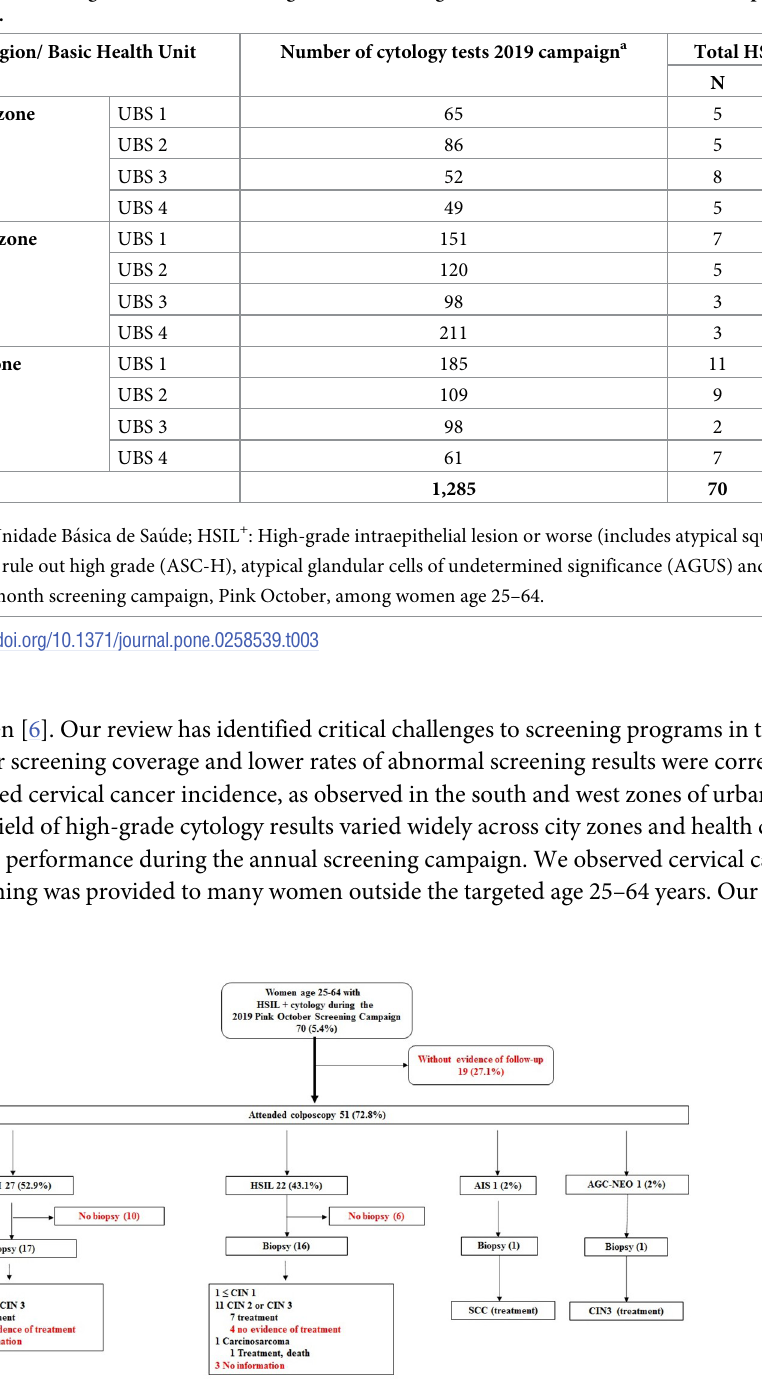
Table 3. Screening tests and results among women attending selected basic health units, 2019 campaign (Manaus, Brazil).